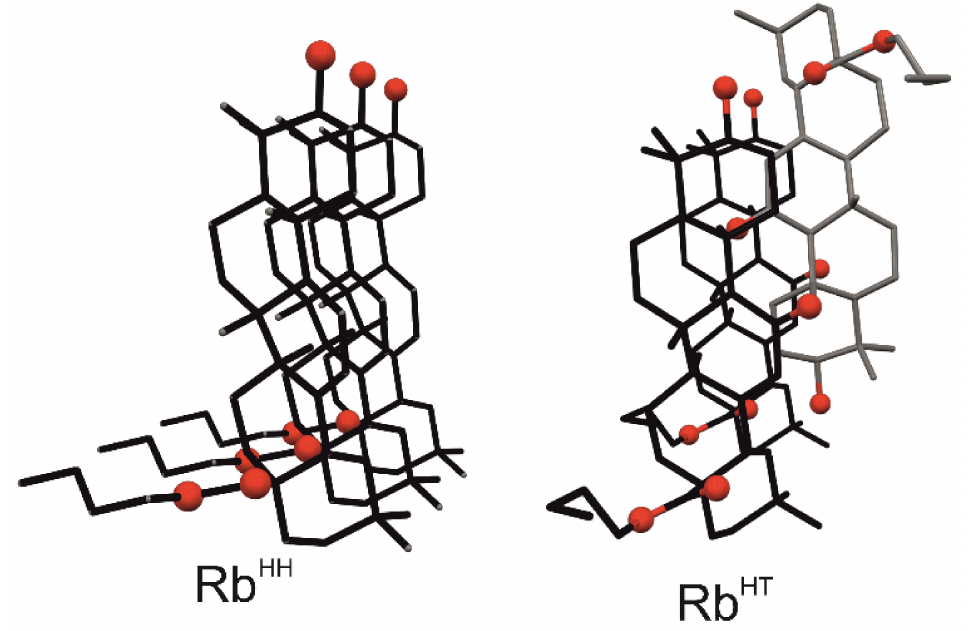
Figure 1. The head-to-head (Rb HH ) and head-to-tail (Rb HT ) ribbons. C-atoms of triterpene skeletons related by 2 1 screw axes in the Rb HT are colored in black and gray